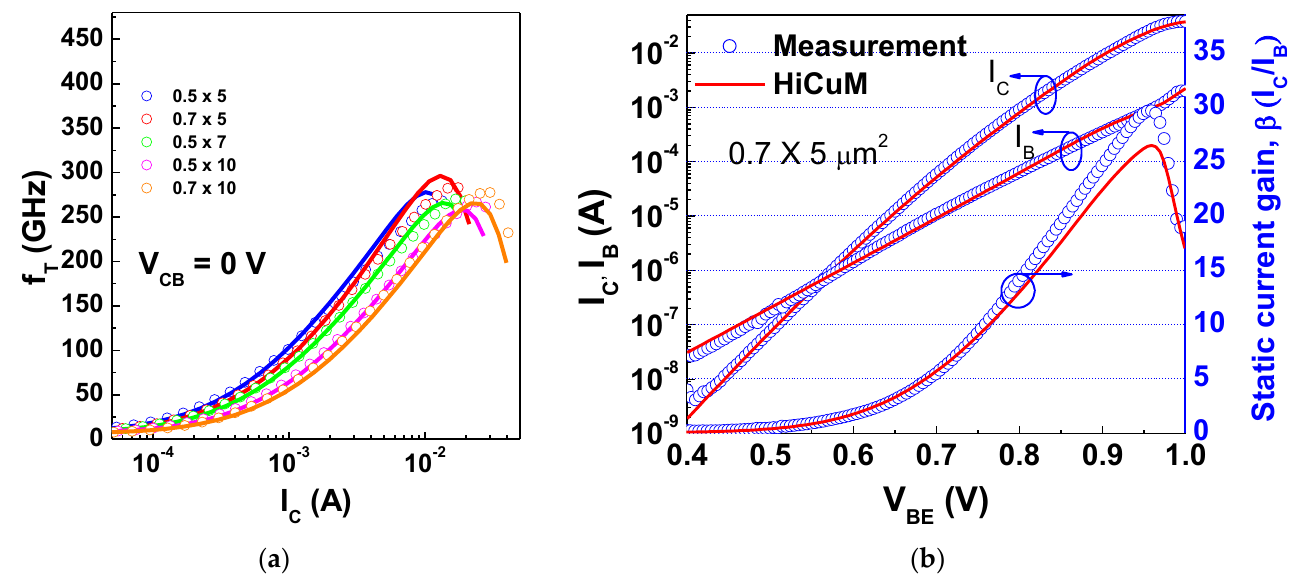
Figure 13. ( a ) Measured and simulated f T versus I C for several transistor geometries; ( b ) Gummel plots and static current gain curve superimposition between measurement and HiCuM simulation.